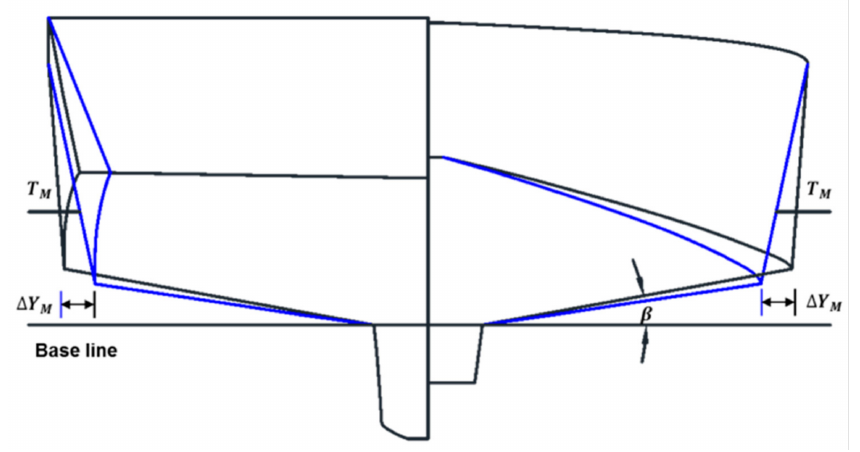
Figure 5. Design variables for hull form